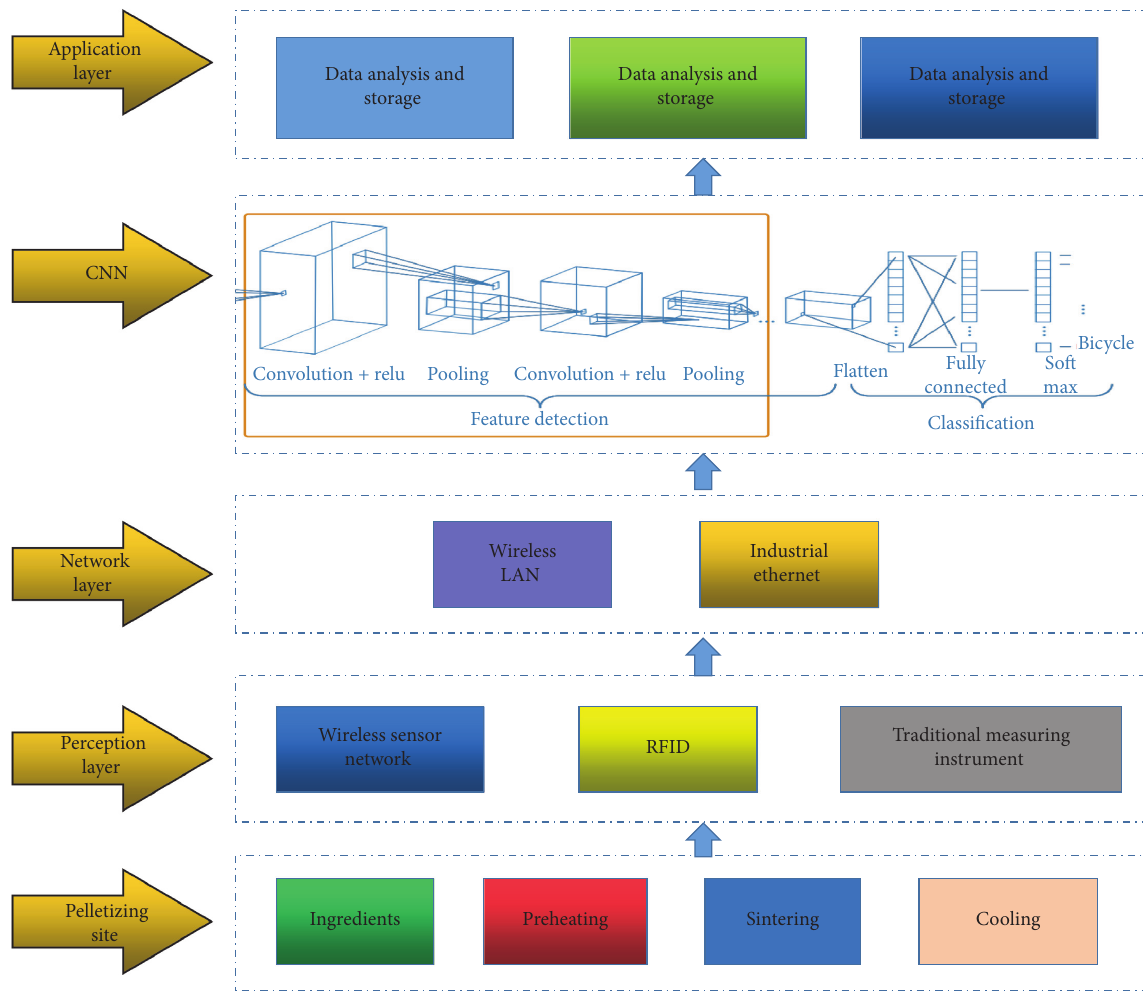
Figure 7: A pelletizing management system based on CNN and IoT